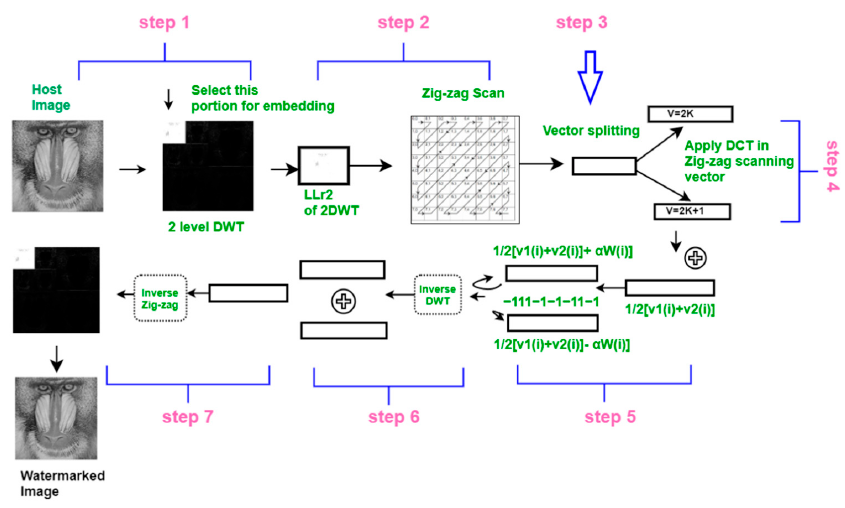
Figure 4. Embedding procedure of 2DWT-DCT watermarking.